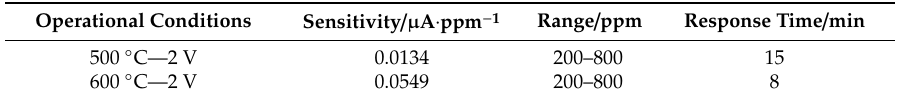
Table 1. Sensitivity results obtained from chronoamperometry tests with the SrCeZrYb sensor at 2 V and at 500 °C and 600 °C.